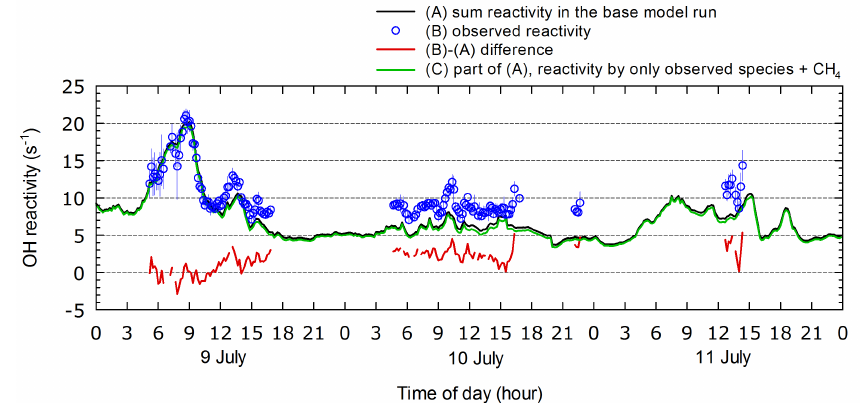
Fig. 5. OH reactivities observed by Tokyo Metropolitan University group (B, blue) compared with the sum of OH reaction rates with respect to all chemical species (A), including those measured and others calculated in the Base run (black). Green (C) shows the fraction of calculated reactivities attributable to reactions with observed species (including methane). The difference between the observed (B) and modeled total (A) reactivities is shown in red; this is used as a basis for calculating amounts of additional hydrocarbon assumed in further model runs.